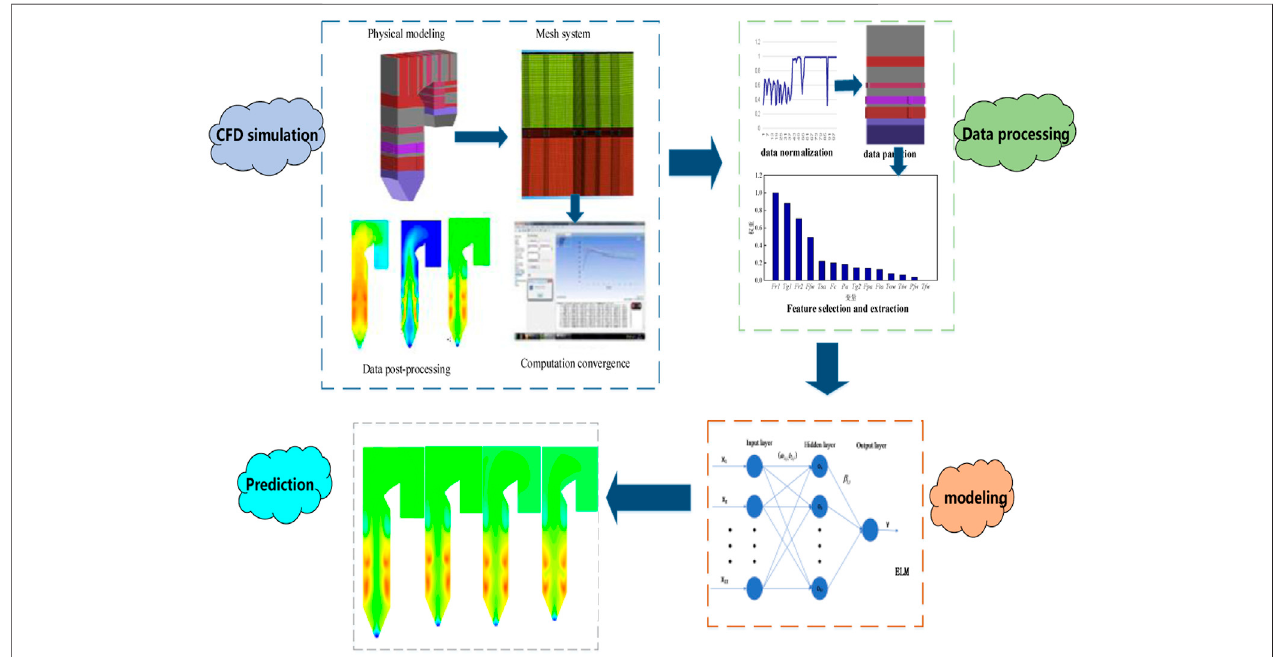
FIGURE 2 | Modeling framework to obtain the 3D NO X distribution in the furnace.